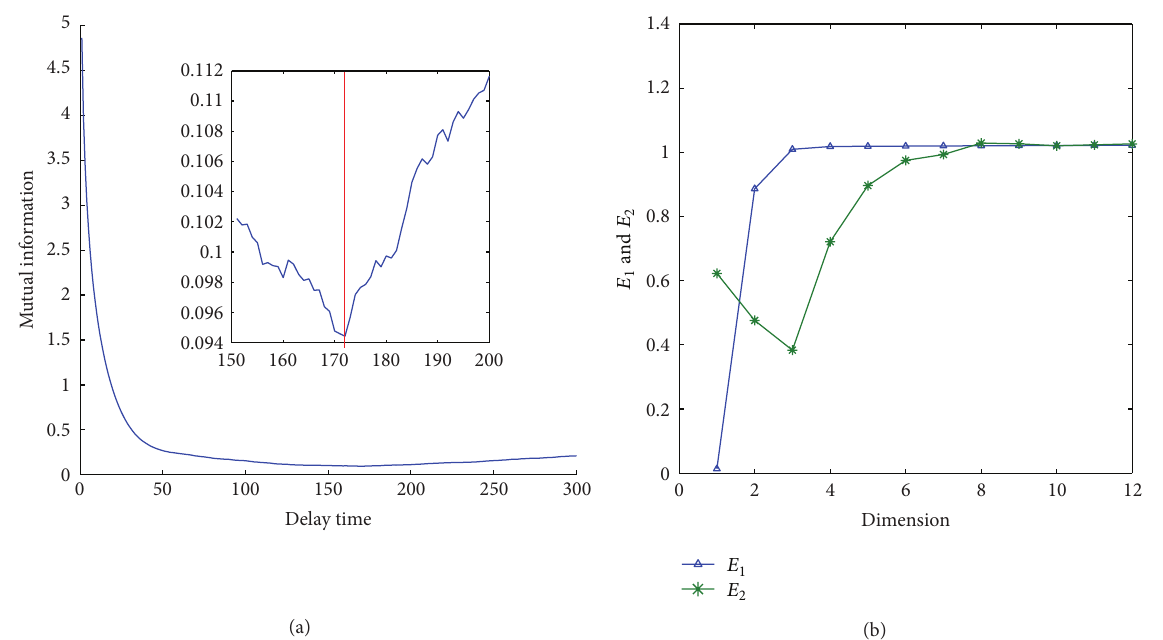
Figure 3: Determination of the proper delay time and embedding dimension of the lateral vibration ( 𝜏 = 172 , 𝑑 = 8 ).